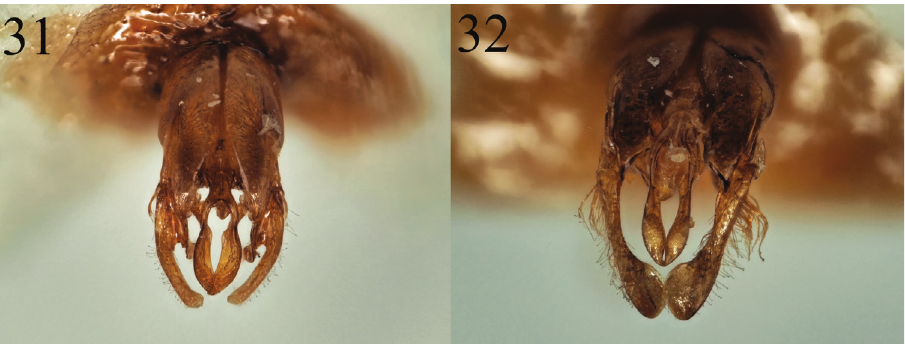
(Fig. 5) ........................................................................ Avpanurgus